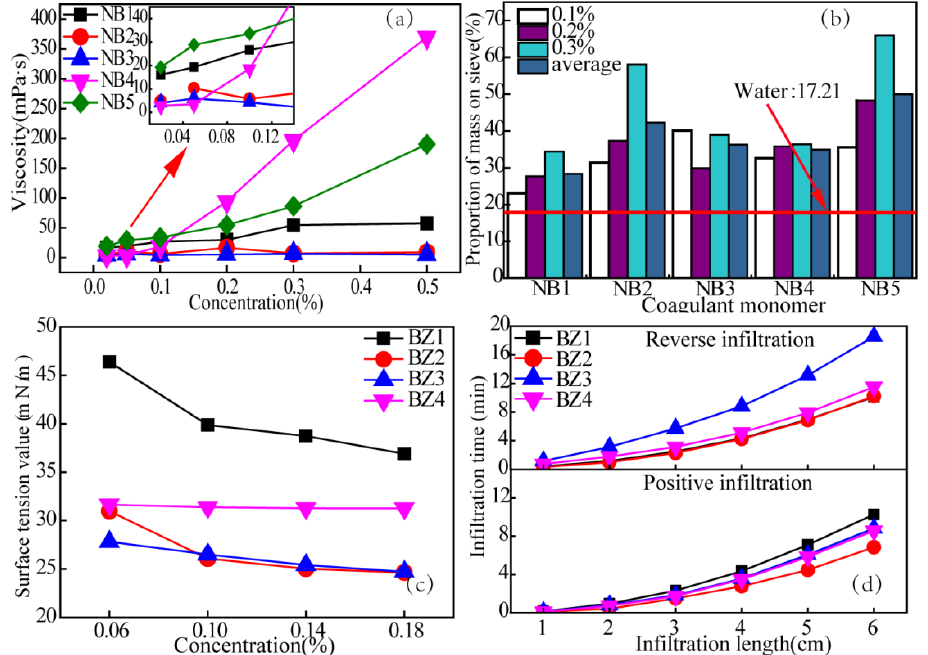
Figure 3. ( a ) Viscosity curve of coagulant solution with concentration; ( b ) mass proportion of dust with large particles; ( c ) change curve of surface tension of surfactant solution with concentration; ( d ) change curve of infiltration time with infiltration length.